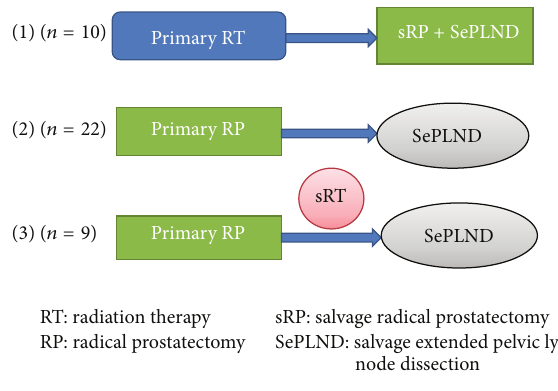
Figure 1: Schematic sequence of treatment options by groups ( 𝑛 = 41